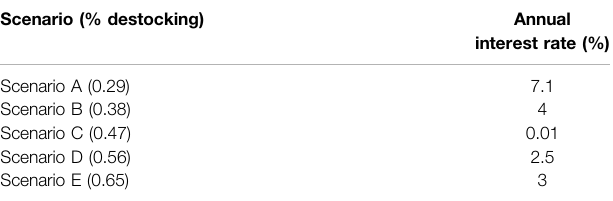
TABLE 7 | Maximum annual interest rate (%) at which the household could repay within 4 years a credit loan used to cultivate grass in the initial project year for each with-project scenario